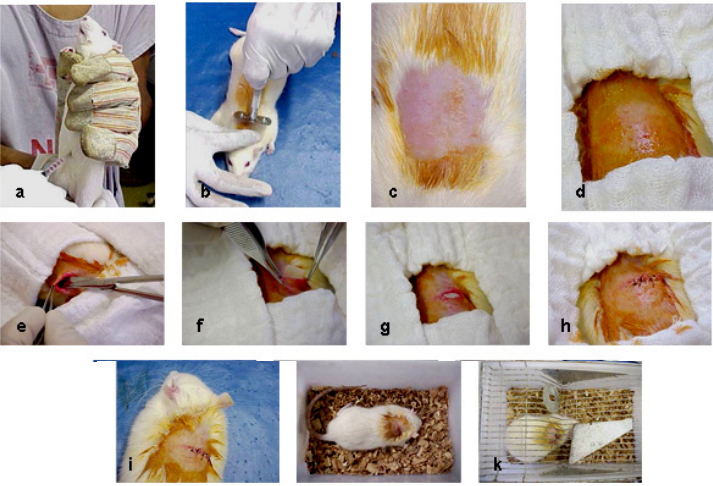
Fig. 1 - A – I) Step-by-step subcutaneous implantation technique; J – K) observation.